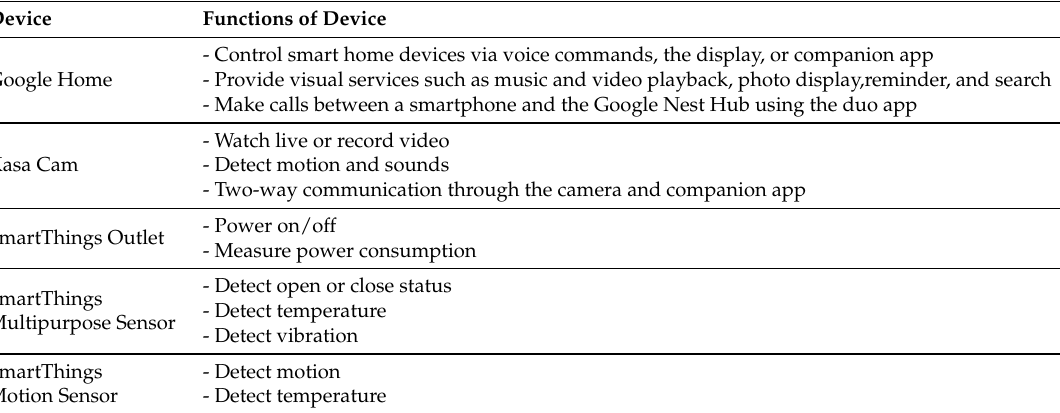
Table 3. Functions of smart home devices.